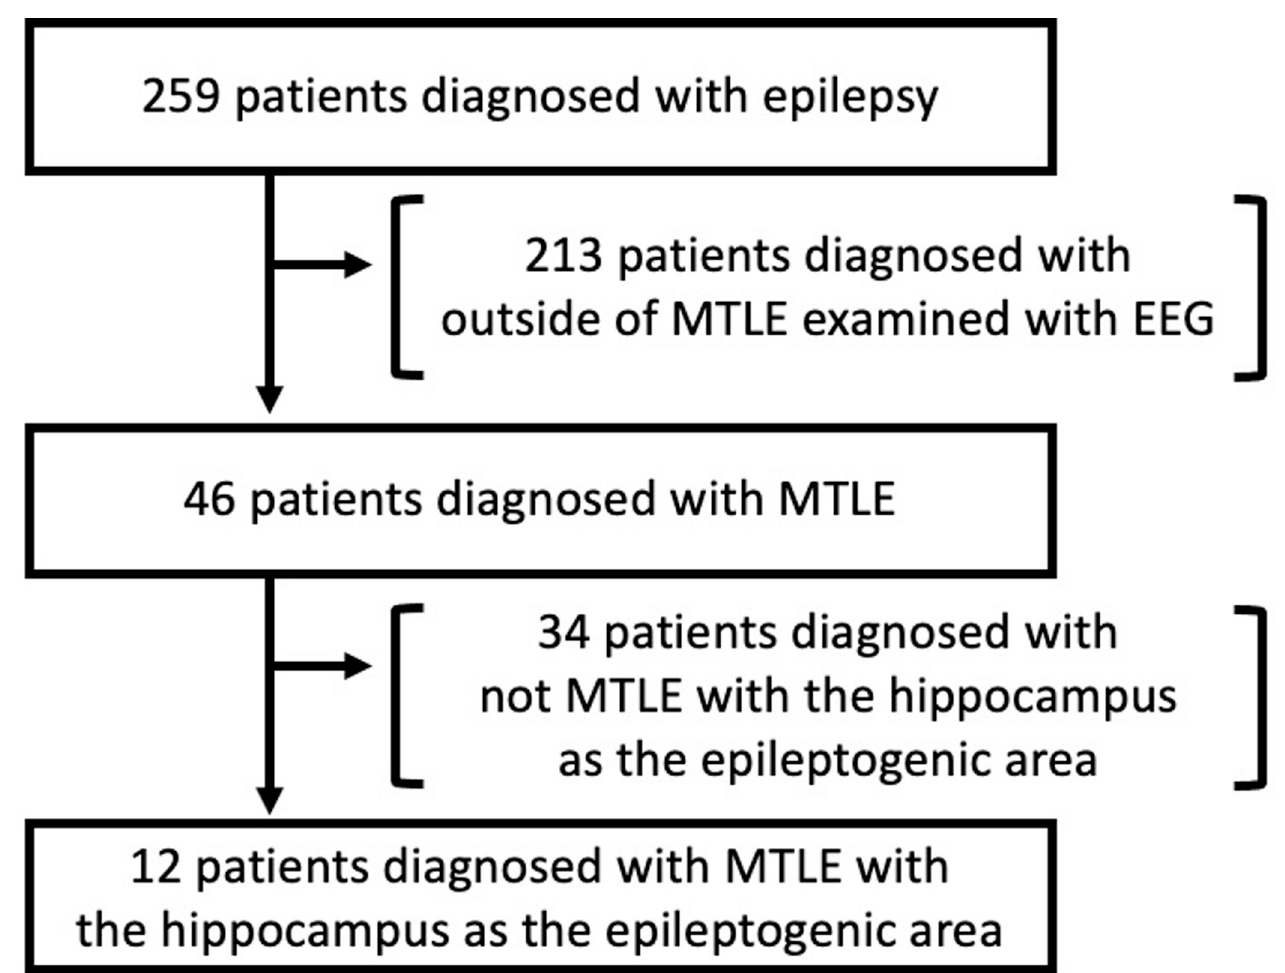
Fig 1. Flow chart for the diagnosis of MTLE with hippocampal epileptogenic area by artificial intelligence (AI) and board-certified neurosurgeons. The data of 259 patients with epilepsy were retrospectively analyzed. However, 213 patients without MTLE were excluded. Twelve patients with confirmed diagnosis of MTLE, with the epileptogenic area in the hippocampus, were enrolled in the study.